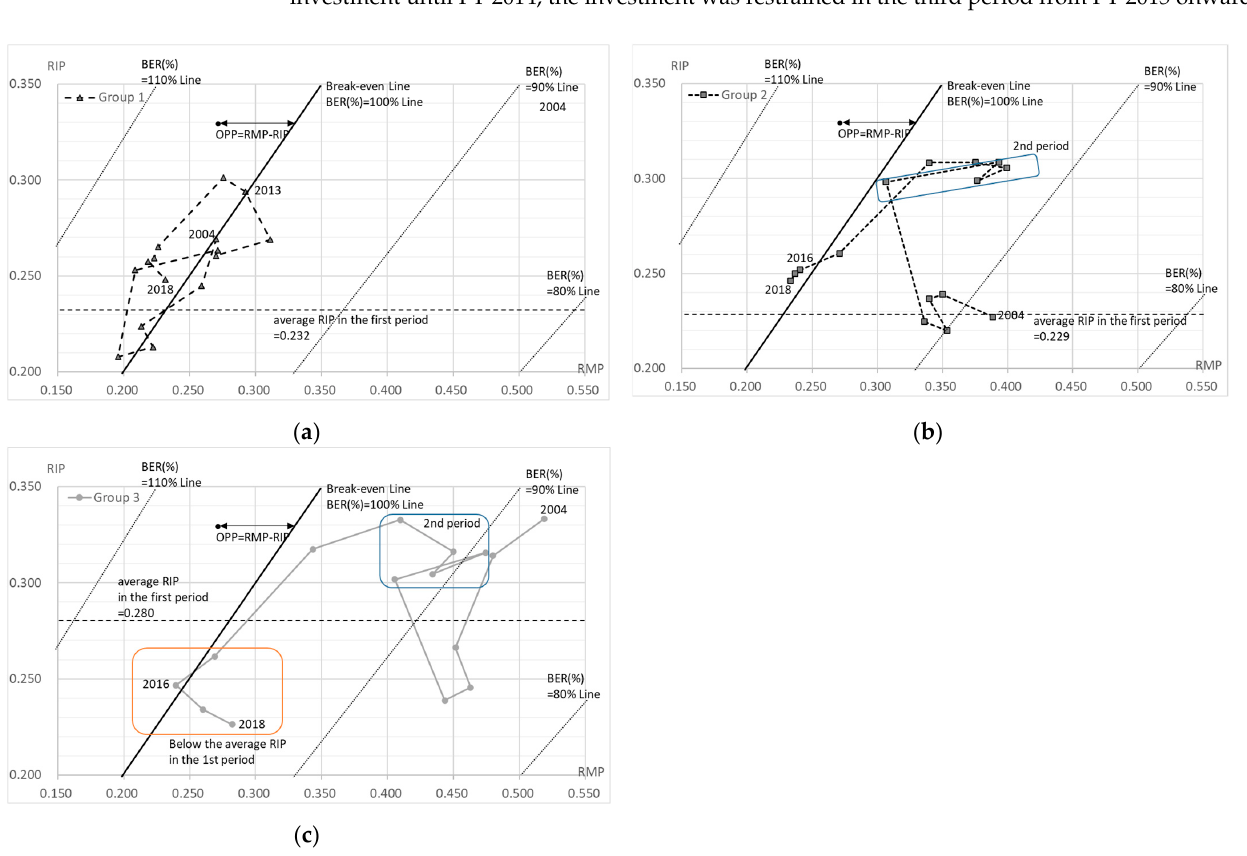
Figure 5. RMP, RIP, OPP, and BER in hospitals offering acute-phase medical care. ( a ) Group 1 (<350 beds); ( b ) group 2 (350–499 beds); ( c ) group 3 (>500 beds). The OPP shows the difference between RMP and RIP; OPP = RMP − RIP. Break-even Line; RIP = RMP. 90% of break-even ratio (BER (%)): RIP = 0.9RMP − 0.1, calculated by RIP = BER (RMP + 1) − 1. 80% of BER (%): RIP = 0.8RMP − 0.20. 110% of BER (%): RIP = 1.1RMP + 0.10.